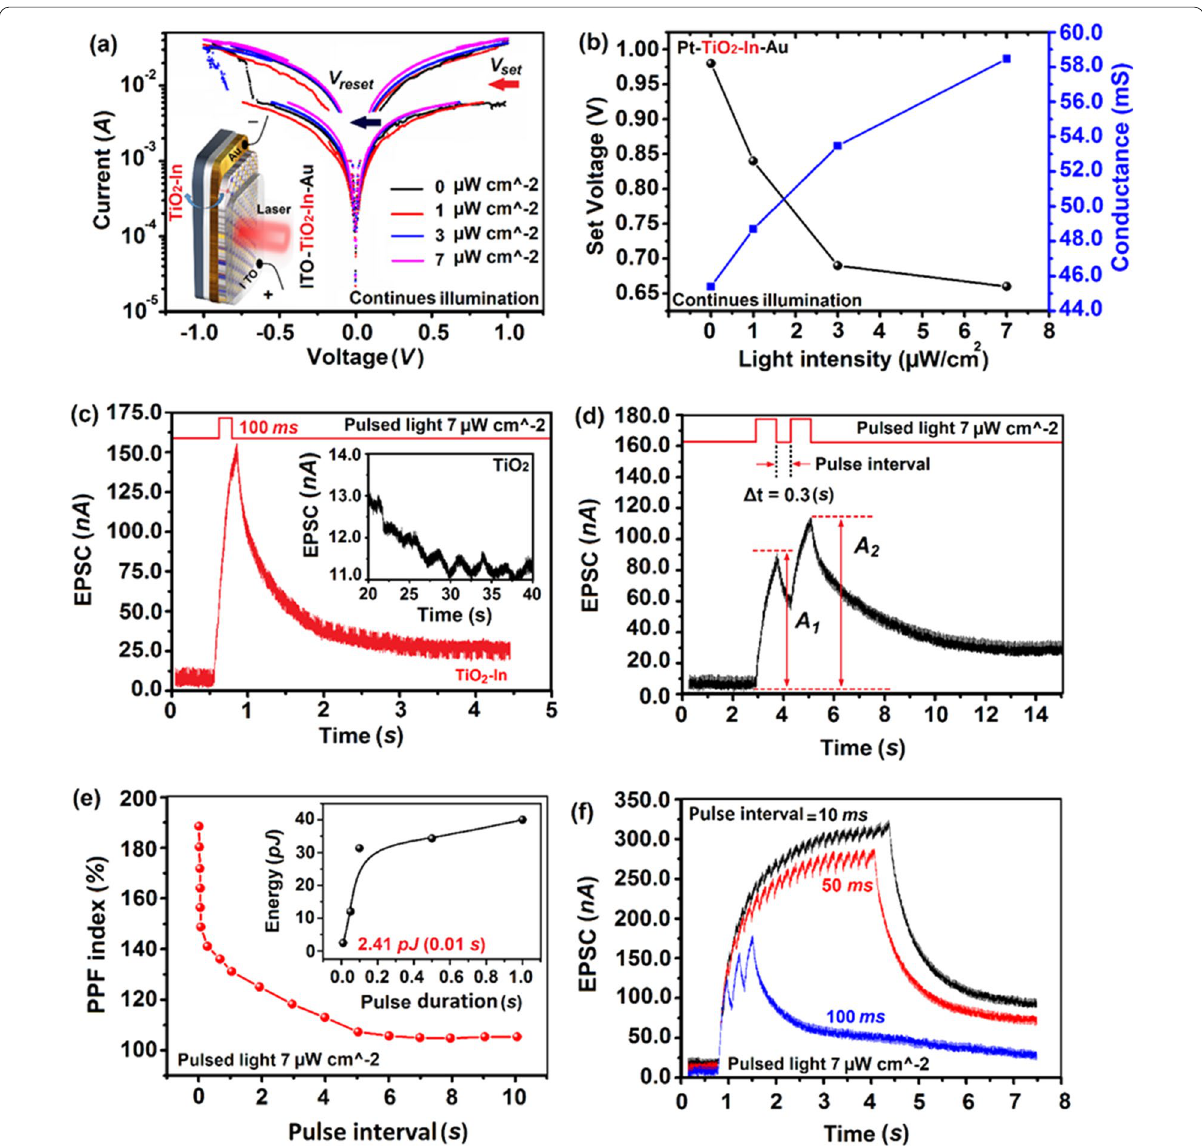
Fig. 19 The optical synaptic characteristics of In-doped ultra-thin TiO 2 films. a The logarithmic scale I–V curves of ITO/In-doped/Au synaptic device. Variation of the set voltage and conductance vs changes of light intensity for pulsed lasers. c The EPSC of synaptic device induced by 7 μW cm − 2 laser pulse. d The PPF of device. e The variation of PPF index vs. the pulse intervals. Inset shows the variation of energy consumption vs. pulse duration. f The variation of EPSC of synaptic device stimulated with the pulsed light with different pulse intervals. Reprinted with permission